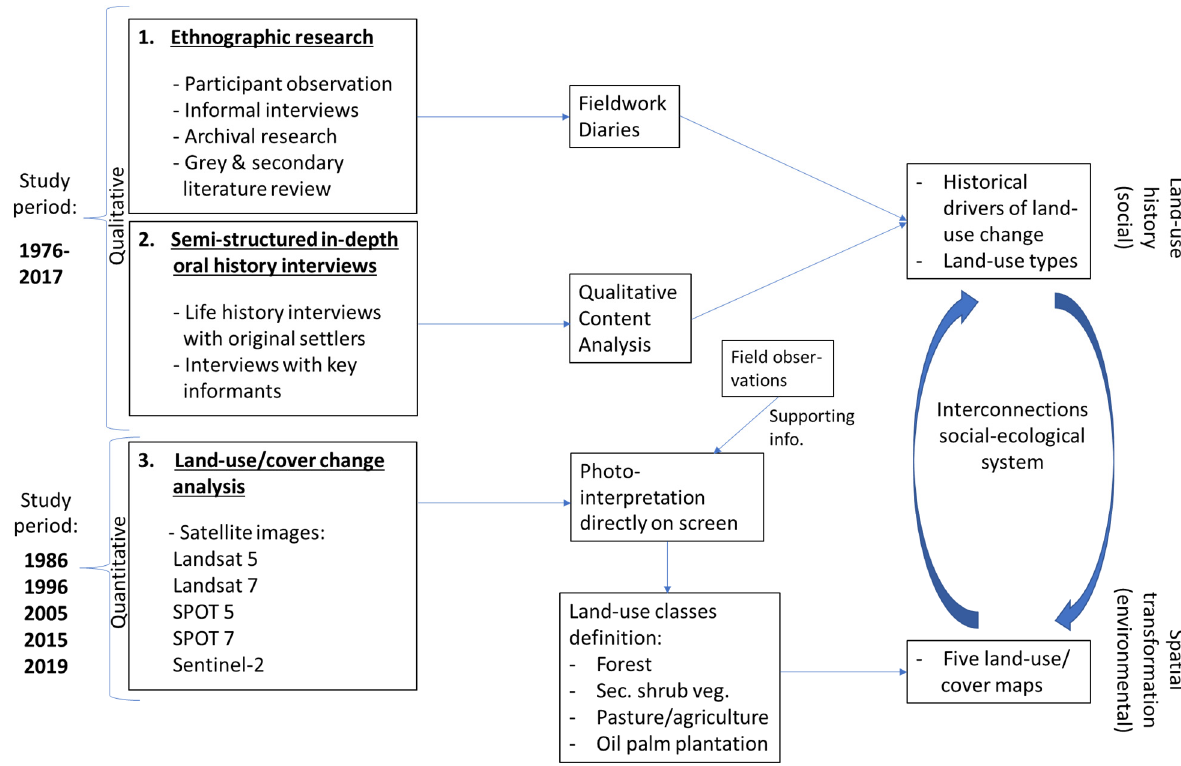
Figure 2. Methodological workflow of the research. Source: own elaboration based on this article’s information.